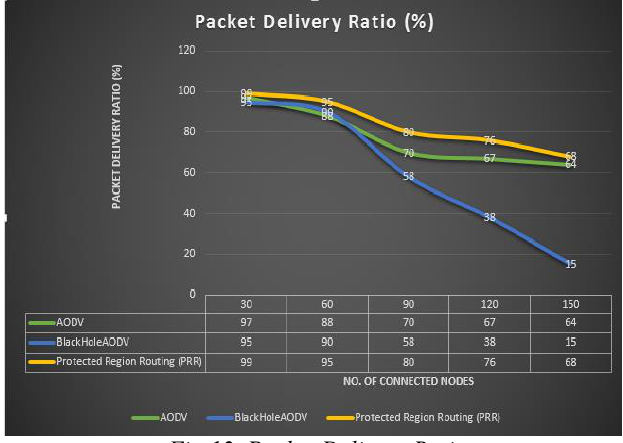
Fig.12. Packet Delivery Ratio